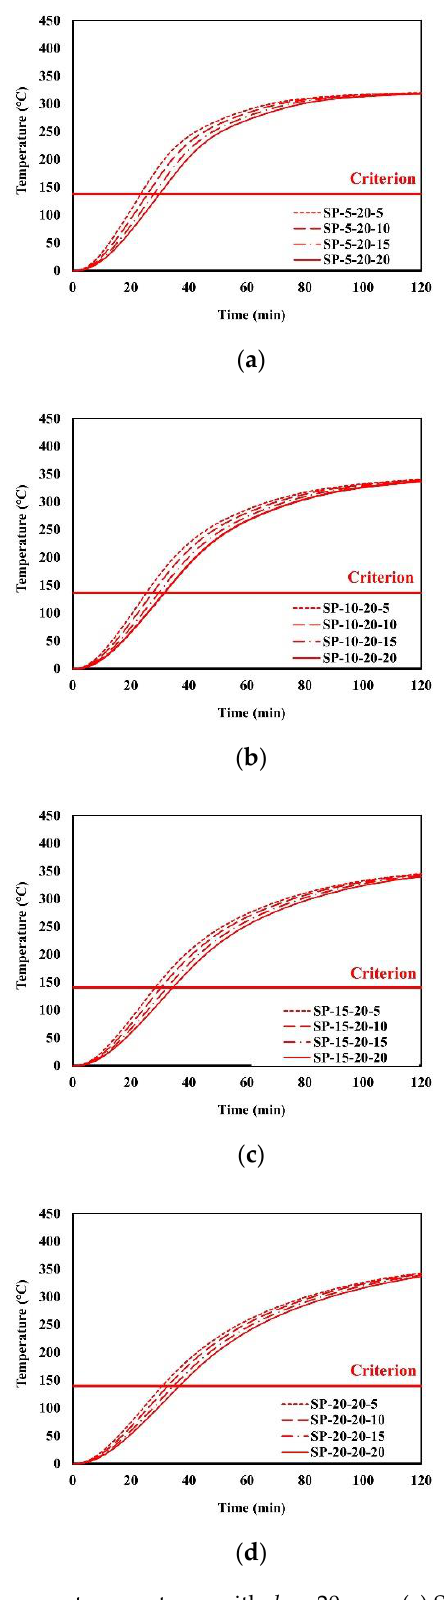
Figure 13. Time history of maximum Figure 14. Time history of average Figure 14. Time history of average temperatures with d p = 20 mm: ( a ) SP-5-20-x; ( b ) SP-10-20-x; ( c ) temperatures with d p = 20 mm: ( a ) SP-5-20- temperatures with d p = 20 mm: ( a ) SP-5-20- SP-15-20-x; ( d ) x; ( b ) SP-10-20-x; ( c ) SP-15-20-x; ( d ) SP-20- x; ( b ) SP-10-20-x; ( c ) SP-15-20-x; ( d ) SP-20- 20-x. 20-x.